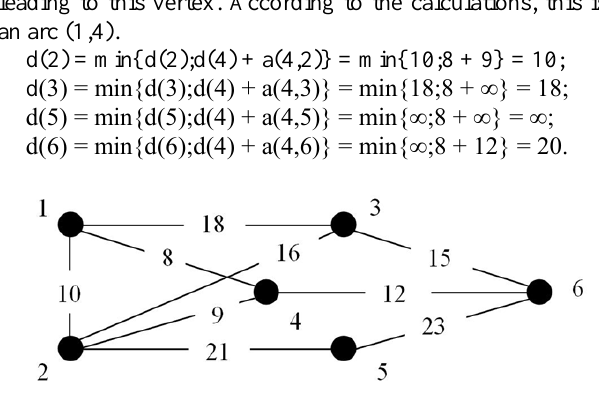
Figure 2. The graph corresponding to Figure 1